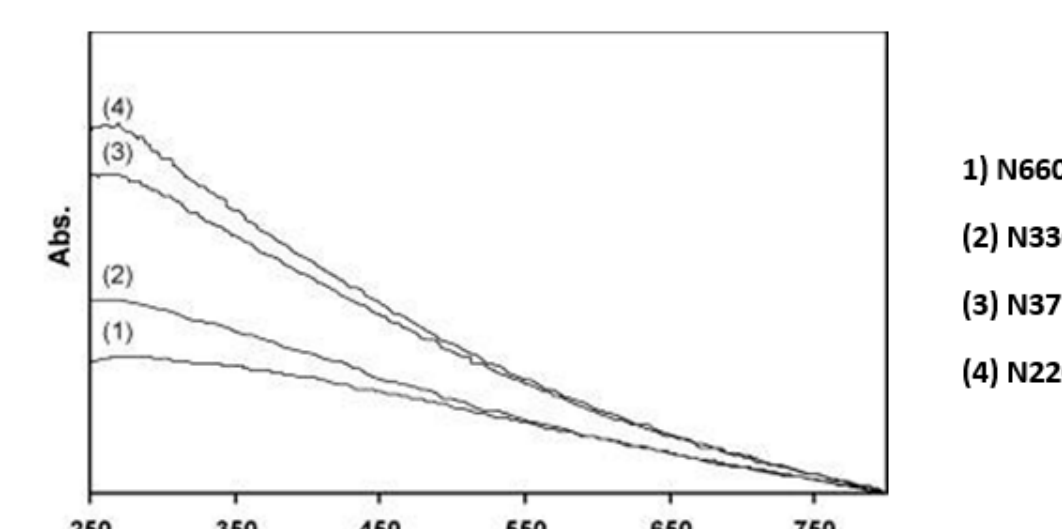
Figure 8. UV-Vis spectroscopy absorbance range of GNPs suspension with different MC amounts. Reproduced with permission from [33], MDPI, 2016.